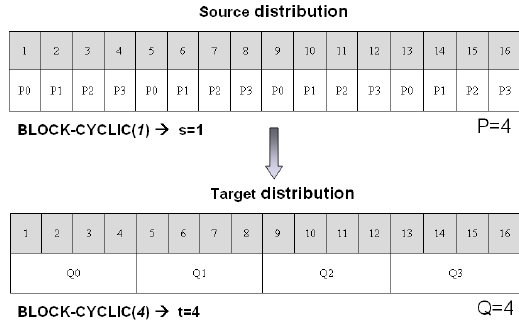
Figure 1. An example for BC (1, 4, 4 ).